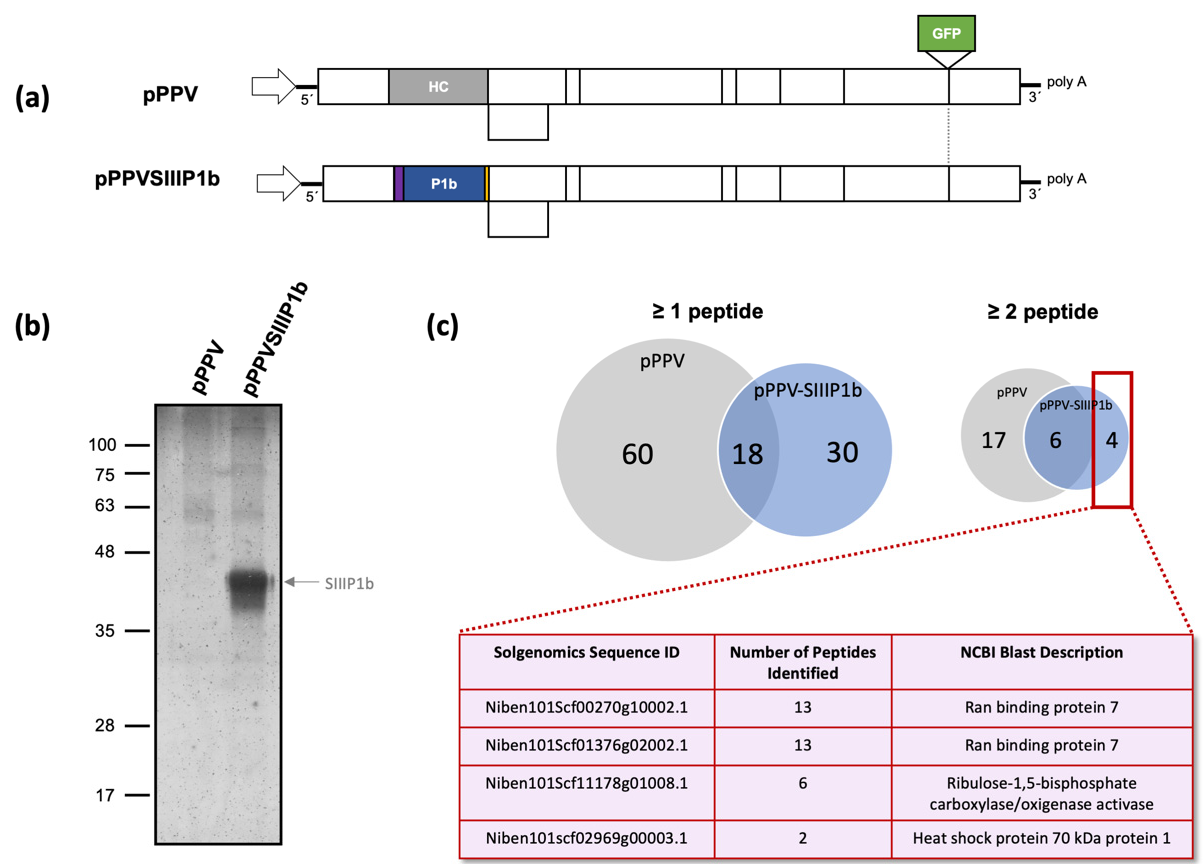
Figure 1. Purification and mass spectrometry analysis of SIIIP1b from PPV- and PPV-SIIIP1b-infected tissue. ( a ) Schematic representation of the two viral constructs employed in this assay. Both encode the GFP sequence between the NIb and CP regions. The purple rectangle represents the SIII tag, and the yellow rectangle represents the NIa cleavage site. ( b ) Silver staining of the SDS-PAGE analysis of PPV and PPV-SIIIP1b samples after elution from the Streptactin resin. The molecular weight is on the left; the arrow on the right indicates the estimated size of the SIIIP1b product. ( c ) Venn diagrams of the mass spectrometry results obtained from the analyzed samples using one or more peptide or two or more peptide identification. The four proteins shown in the table below correspond to the targets found exclusively in the pPPV-SIIIP1b